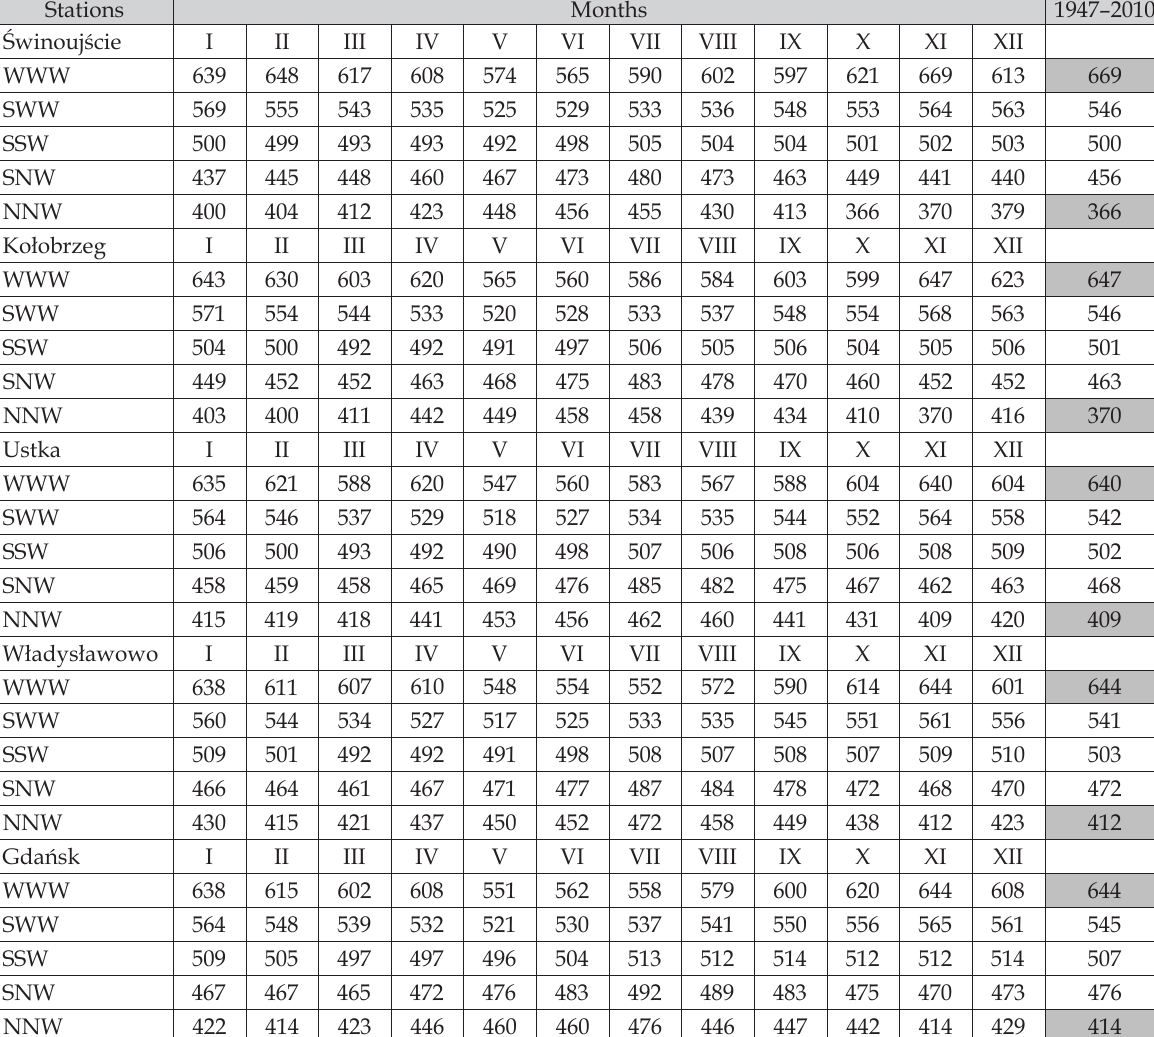
Table 3. Characteristic sea levels [cm] for Świnoujscie, Kołobrzeg, Ustka and Gdańsk from the period 1947–2010